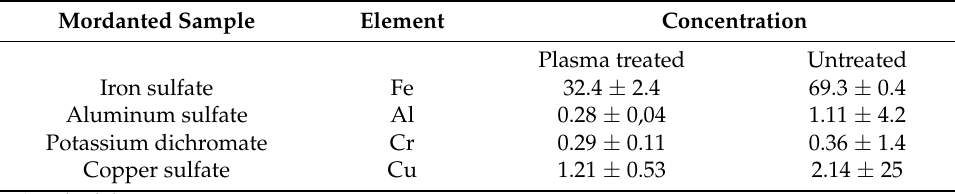
Table 2. Metals concentrations expressed as µ g of metal/mL.